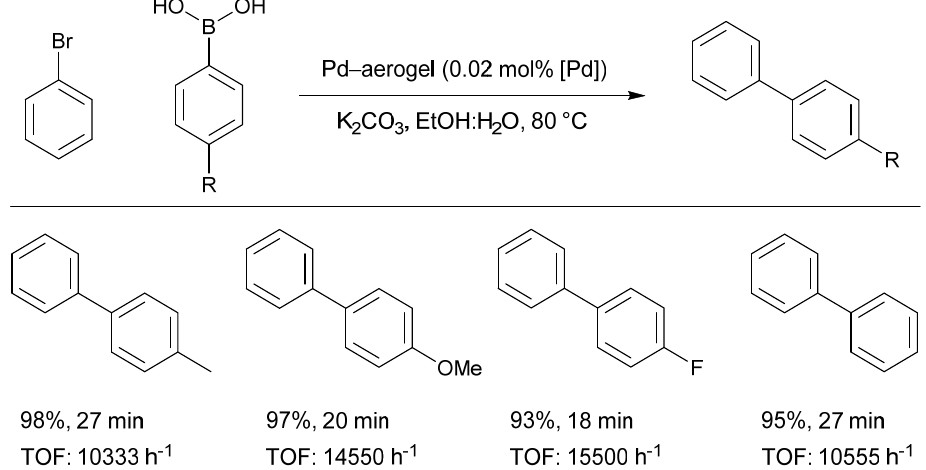
Figure 11. Activity of a palladium ‐ loaded aerogel as a Suzuki–Miyaura catalyst, Reproduced with permission from [99].